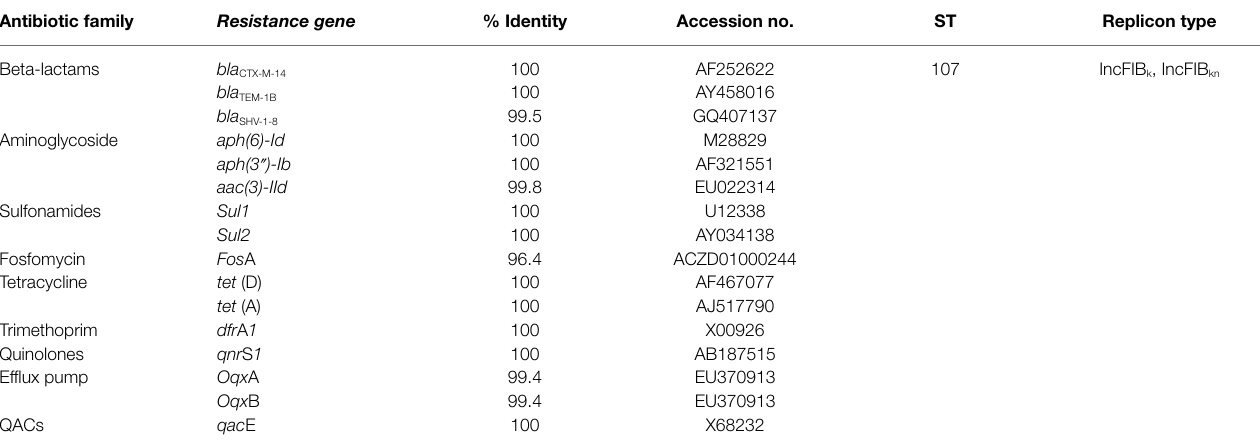
TABLE 3 | Molecular profile of fecal carriage of ESBL- Klebsiella pneumoniae obtained from calves during the rearing period at a Dutch veal farm. Antibiotic